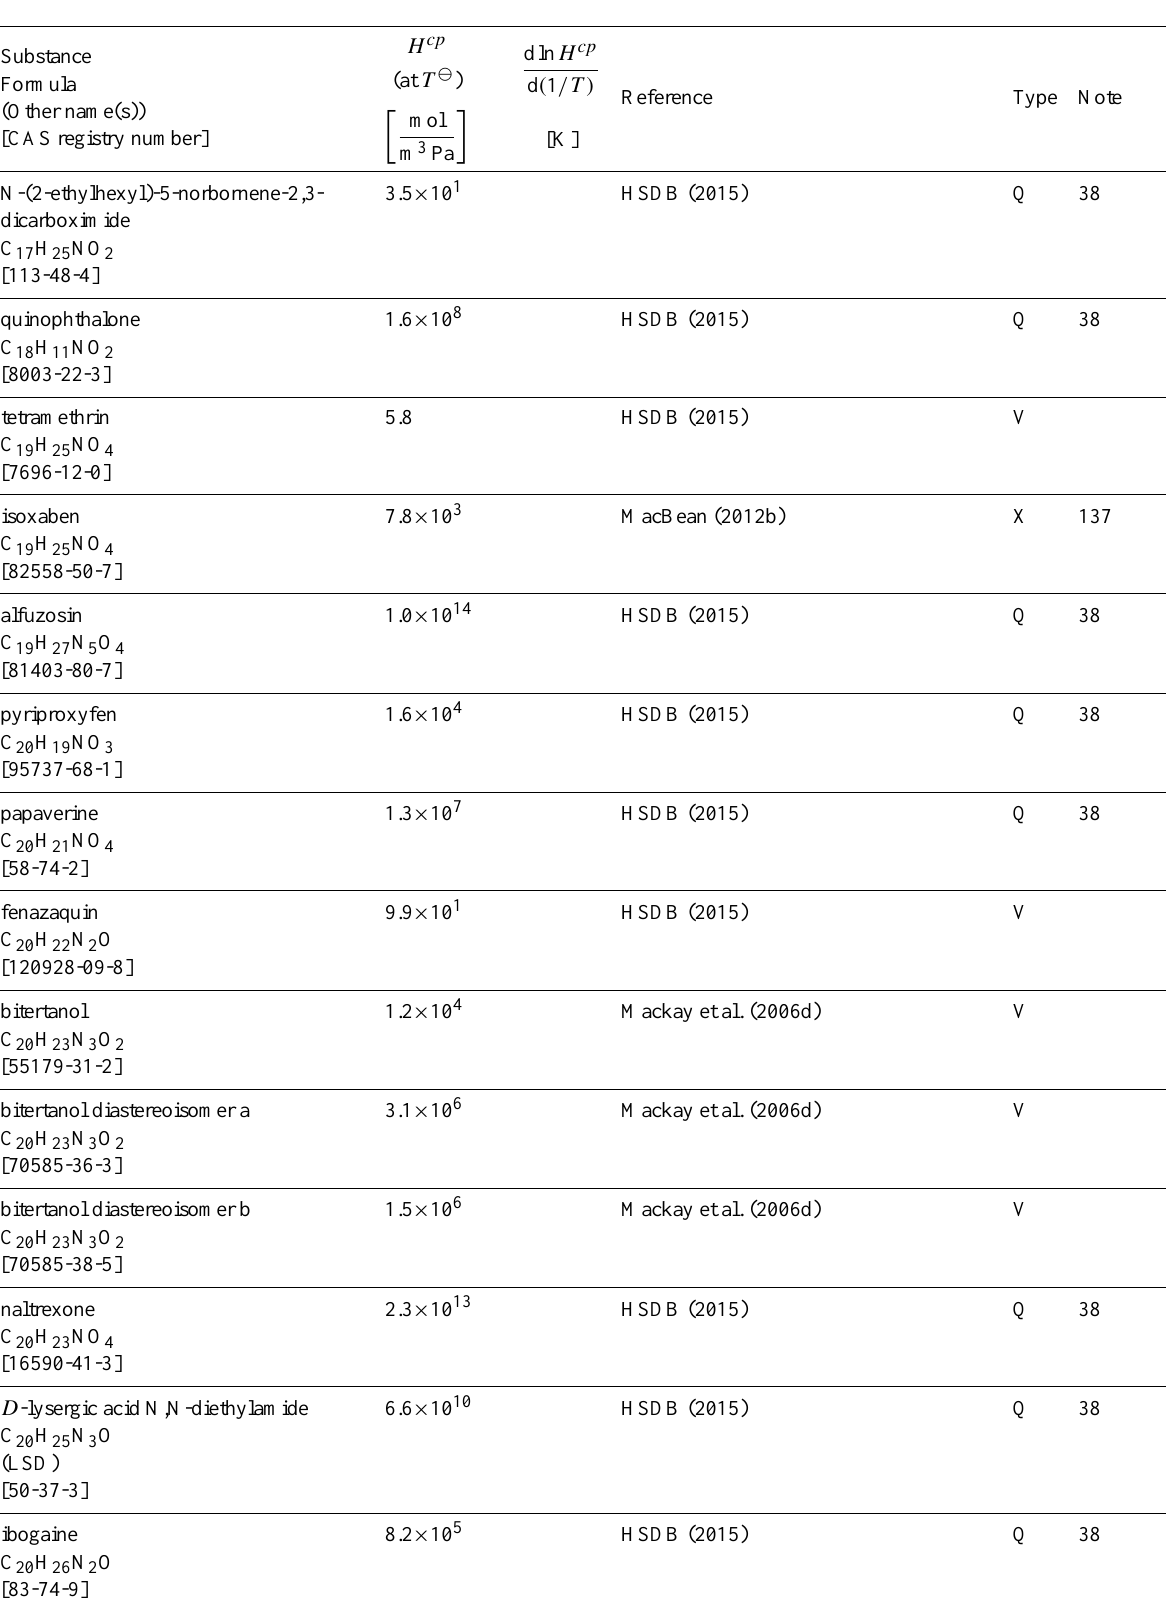
Table 6: Henry’s law constants for water as solvent